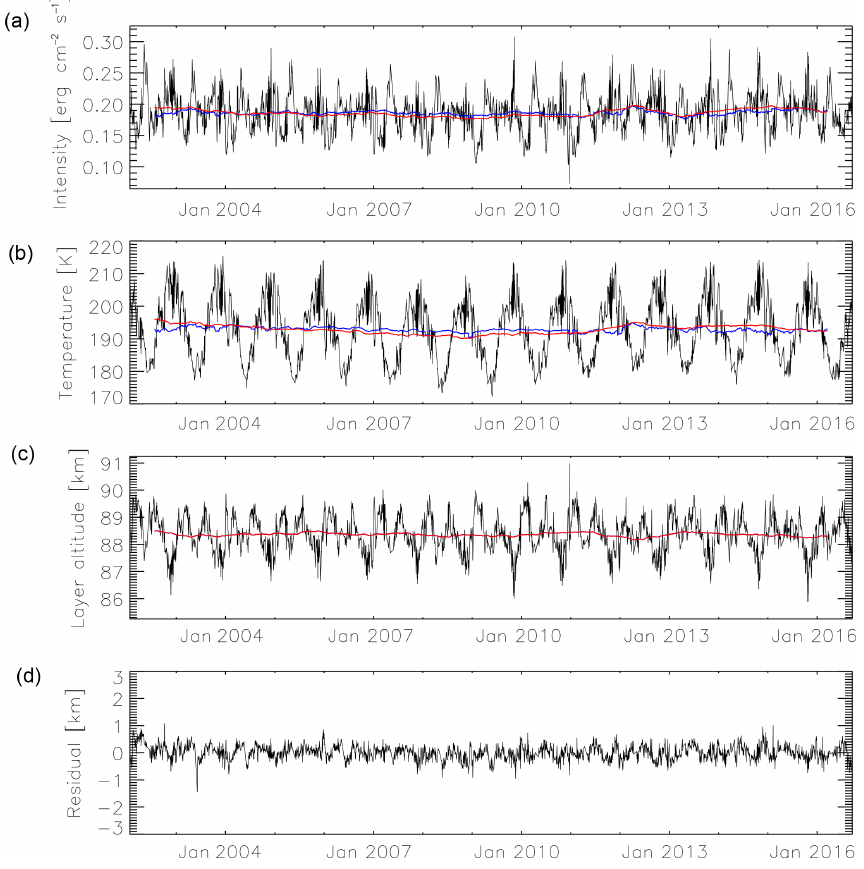
Figure 1. SABER OH intensity (a) , equivalent temperature (b) , VER-weighted altitude (c) and residual altitude (d) after fitting the empirical function (Eq. 3). Black: SABER measurements; red: deseasonalized values (12-month moving averages subtracted); blue: trend (12-month moving averages and solar linear component subtracted). Table 1. Mean, trend and solar component slopes and correlations of deseasonalized SABER OH-VER-weighted altitude, vertically inte- grated OH VER (intensity) and OH-VER-weighted temperature. Means are expressed in meters, ergcm − 2 s − 1 and K, respectively. Trend slopes are expressed in meters per decade, % per decade and K per decade. Solar slopes are expressed in meters per 100s.f.u., % per 100s.f.u. and K per